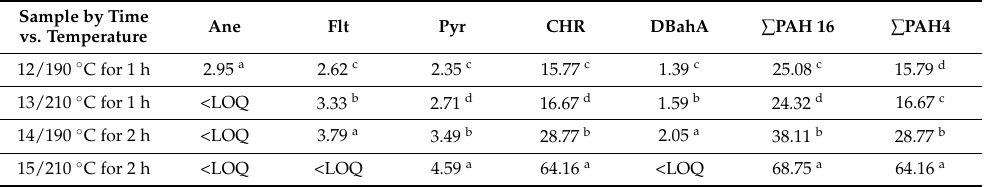
Table 4. PAH values ( µ g kg − 1 ) in samples exposed to 190 ◦ C and 210 ◦ C in dependence of expo- sure